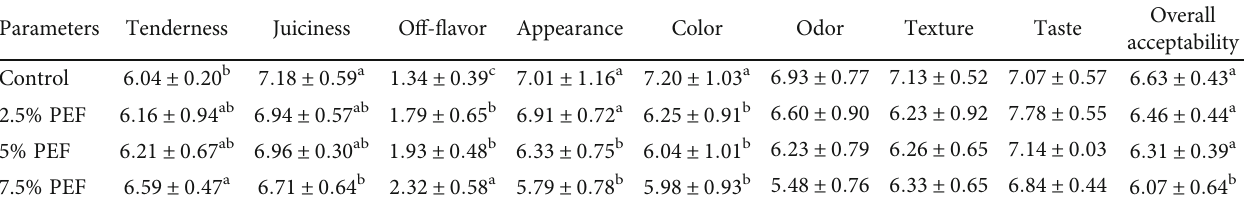
Values are mean ± SD of 3 determinants, samplesize ð n Þ = 5 . a,b,c,d,e Di ff erent letters indicate a signi fi cant di ff erence between storage time ( p < 0 : 05 ). A,B,C,D Means in the same row followed by di ff erent letters are signi fi cantly di ff erent ( p < 0 : 05 ). PEF: purple eggplant fl our; TBARS: thiobarbituric acid- reactive substances. Table 6: Sensory characteristics of beef patties containing di ff erent concentrations of PEF. Parameters Tenderness